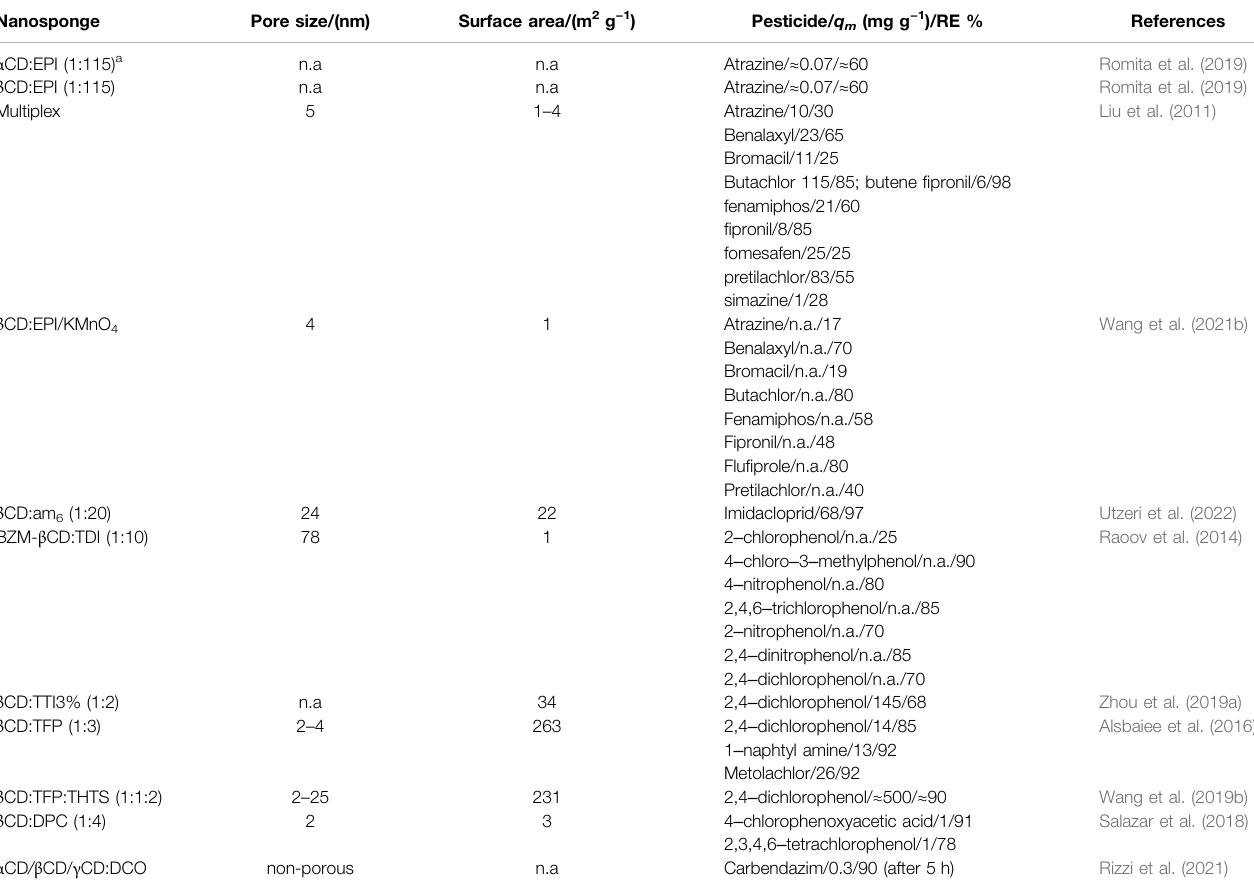
TABLE 6 | The main types of CDNSs applied for the adsorption of pesticides.